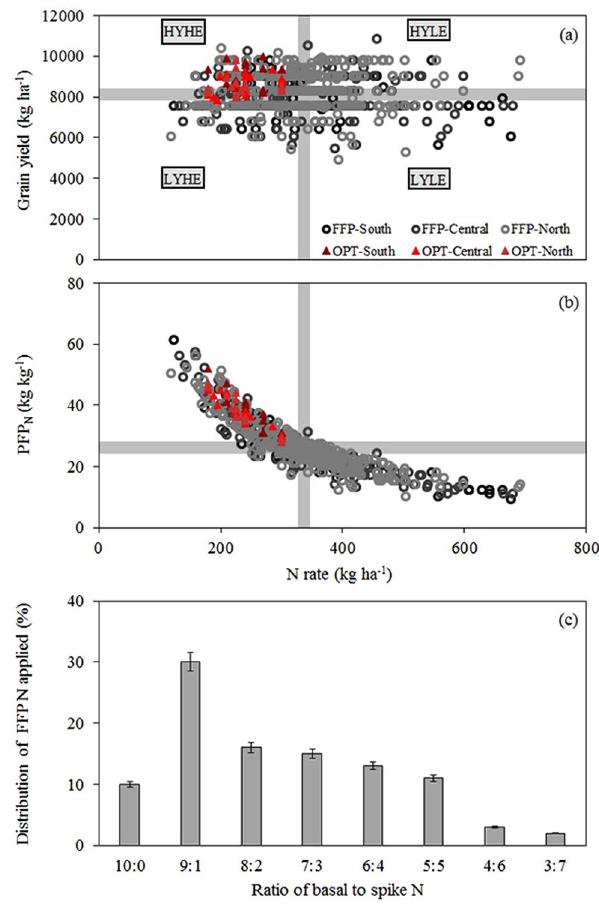
Figure 1. The distribution of yield ( a ) and N partial factor productivity (PFP N , b ) on farmers’ fertilizer practices (FFP) and optimized N managements (OPT), and the distribution of FFP N applied on basal to spike N fertilizer application ratios ( c ) for rice production. The FFP values are from farmer surveys, and the OPT values are from the location experiment. The lengths of the bars (grey colour) are the average values plus 2% of the N rate, grain yield and PFP N . The short bars labelled HYHE, HYLE, LYHE and LYLE represent high yield and high efficiency, high yield and low efficiency, low yield and high efficiency, and low yield and low efficiency,